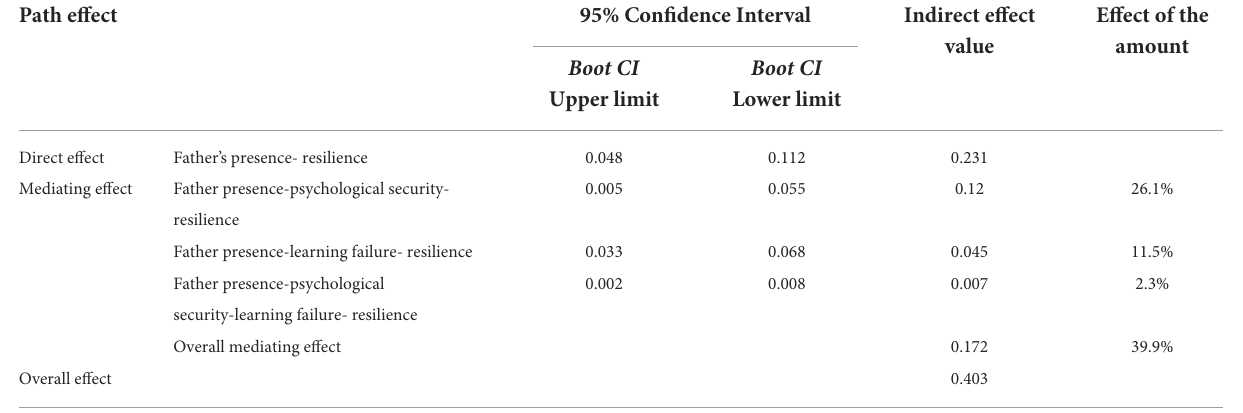
TABLE 2 Chain mediating effect analysis of psychological security and learning failure (N =